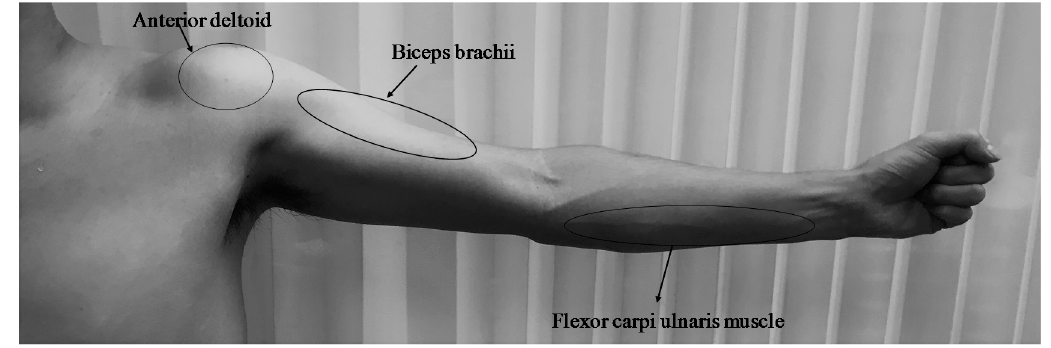
Figure 7. Arm muscles involved in the driving operation.